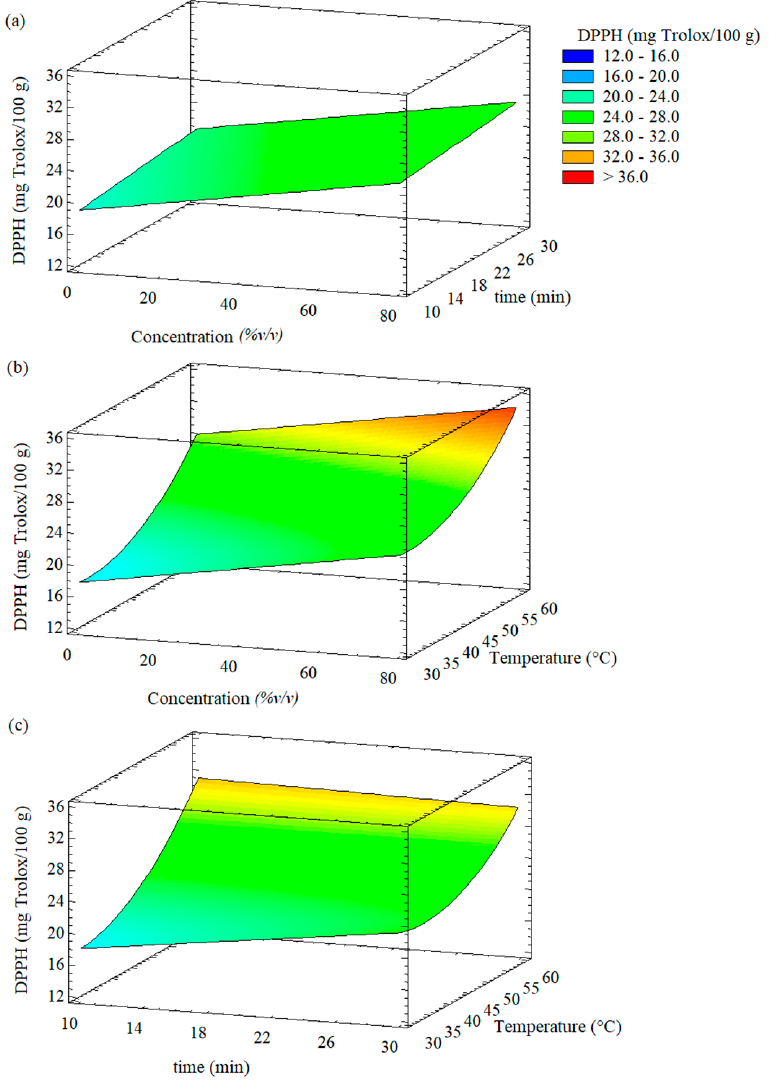
Figure 5. Response surface plots showing the effect of different experimental factors on the DPPH radical scavenging activity of the extracts from Welsh onion leaves: ( a ) effect of ethanol concentration and time; ( b ) effect of ethanol concentration and extraction temperature; ( c ) effect of time and extraction temperature.